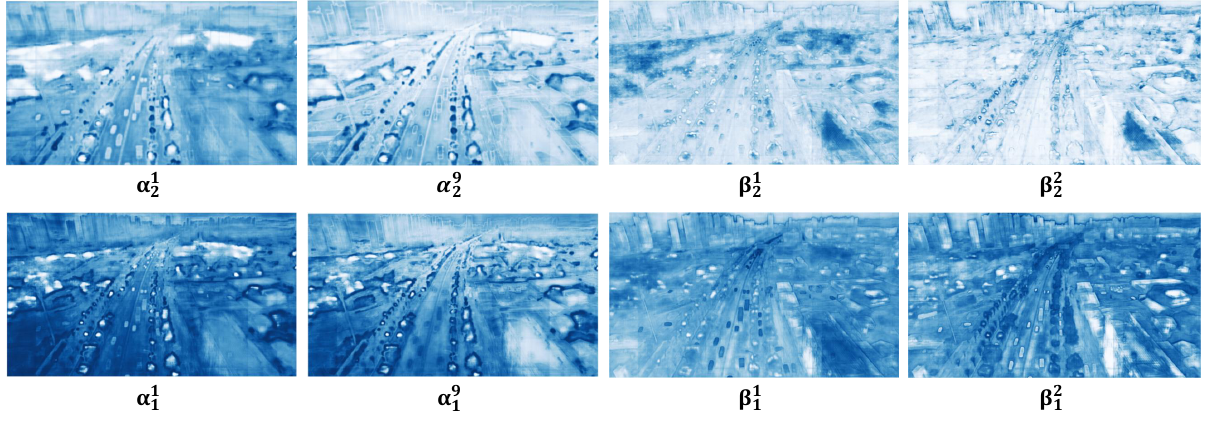
Figure 9. Attention analysis of different scales. We select 4 attentions from each of the Attn1 branch and the Attn2 branch. α, β are of the same meaning as in Figure 5. The superscripts are the channel index of the attentions. α 2 , β 2 correspond to the attentions predicted in the 0 . 5 × scale and the 2 × scale. α 1 , β 1 are predicted in 1 × scale. Brighter color means higher value. Best visualized with zoom